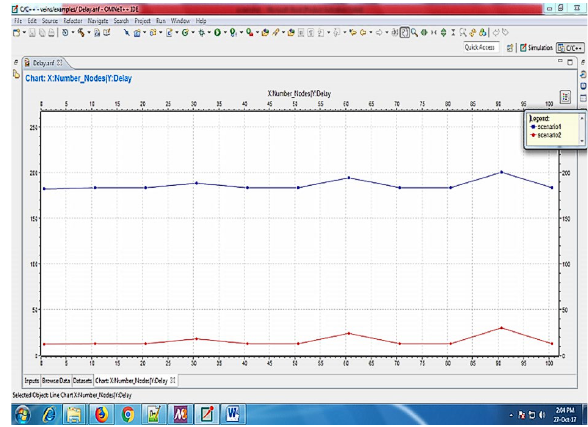
Figure 14. Latency graph for different number of nodes Figure 15. Wi-Fi monitoring software front